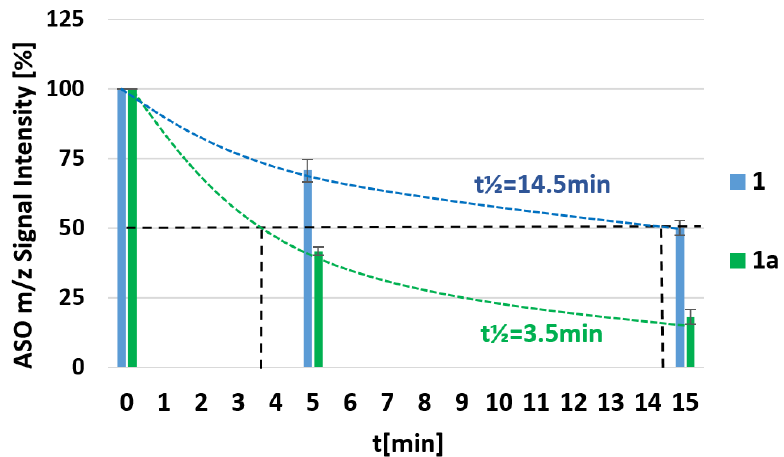
Figure 6. Analysis of the hydrolysis rates of 1 and 1a (1:1 mixture) in the presence of svPDE. The % contents of intact 1 and 1a were calculated after 0, 5 and 15 min of hydrolysis based on the relative intensities of the peaks in MALDI-TOF MS spectra. The sums of the relative intensity of the peaks corresponds to the intact oligomers and their two major fragments (12 nt and 11 nt) were taken as 100% at each time point. SD ± values are marked. The roughly estimated T 1/2 values were assessed, as shown.